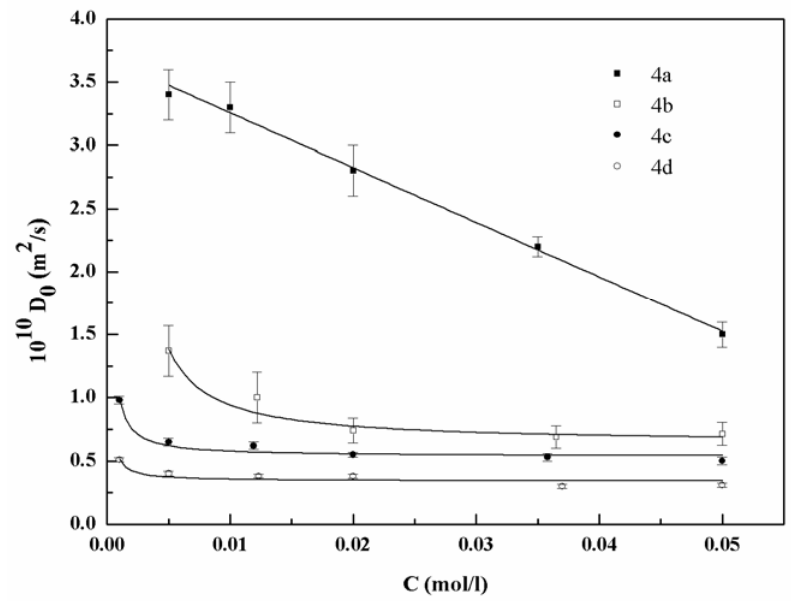
) vs. surfactant concentration (C) for surfactants 4a–d . Figure 6. Diffusion coefficient (D 0 Lines represent the fits by the model described in the